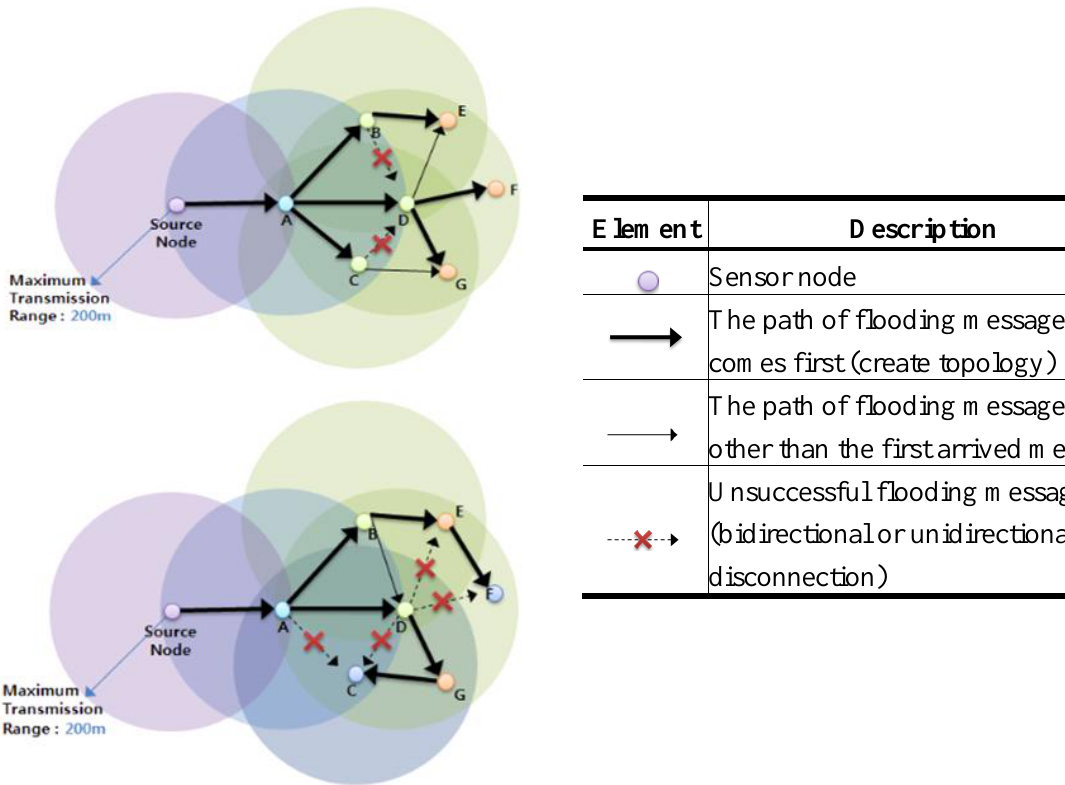
Figure 6. Example of topology change.